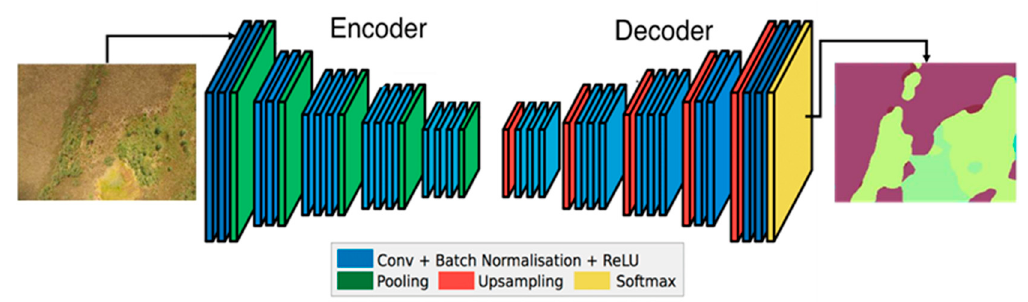
Figure 6. SegNet architecture for semantic segmentation for bog-ecotope semantic segmentation.